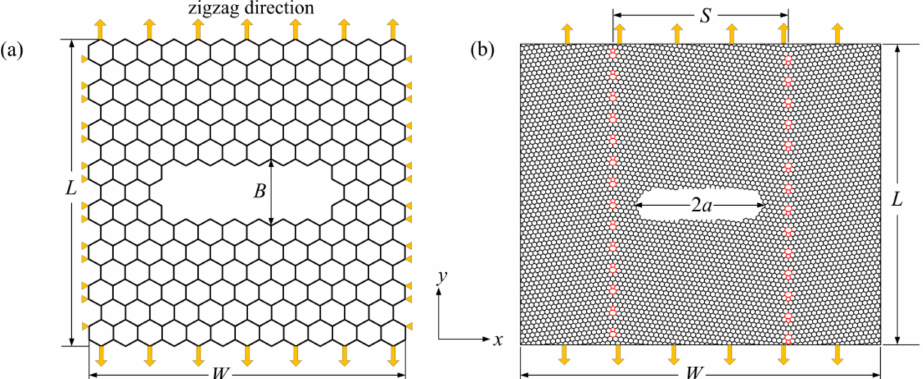
Figure 4. The graphene models containing a central crack: ( a ) zigzag-oriented monocrystalline graphene; ( b ) polycrystalline graphene with two antisymmetric zigzag-oriented